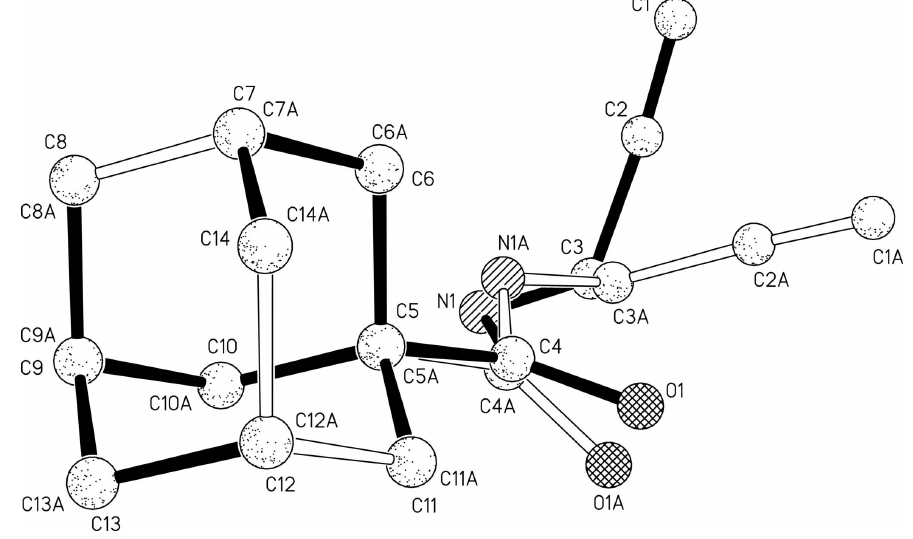
Figure 3 Superposition plot of the title compound (bold bonds) and the formerly reported polymorphic structure (Mol. A, open bonds). For better insight plot without Hydrogen